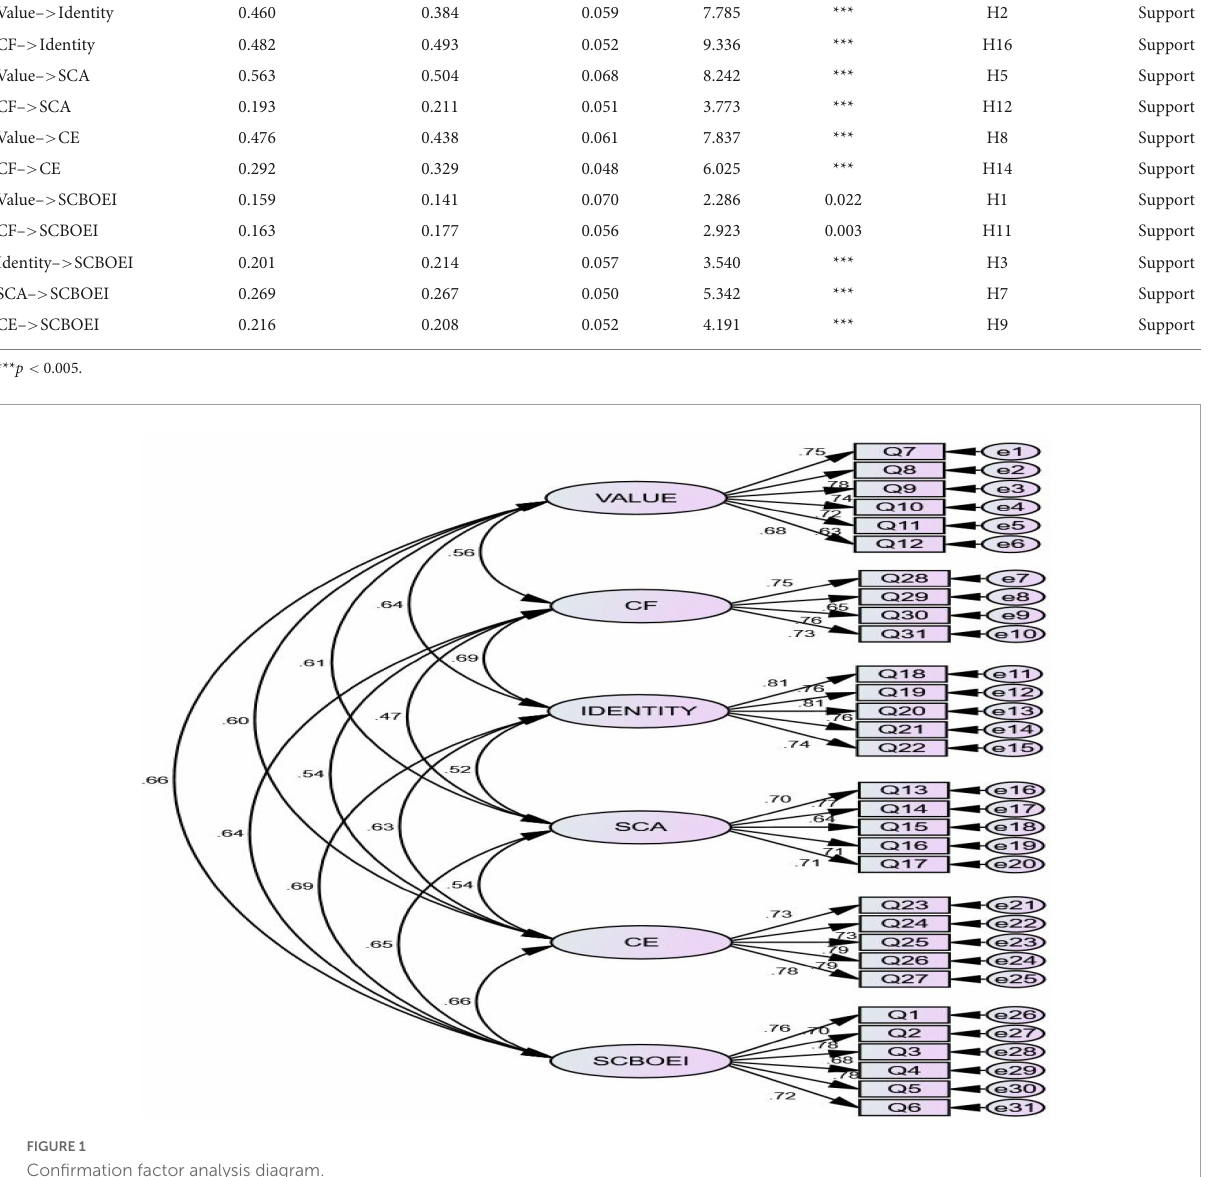
Table 11 inspires: Gender has no significant effect on